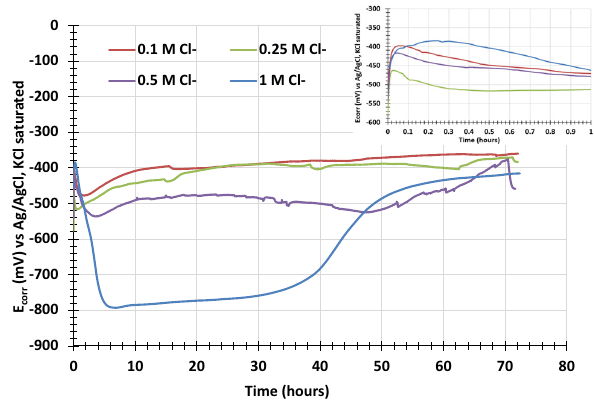
Figure 3: E corr of HSHCsw at open circuit in deaerated electrolytes at pH 13.4 at 0.1, 0.25, 0.5, and 1 M Cl − over a 3 - day period. Right top is the magnifying graph of the fi rst hour of immersion.